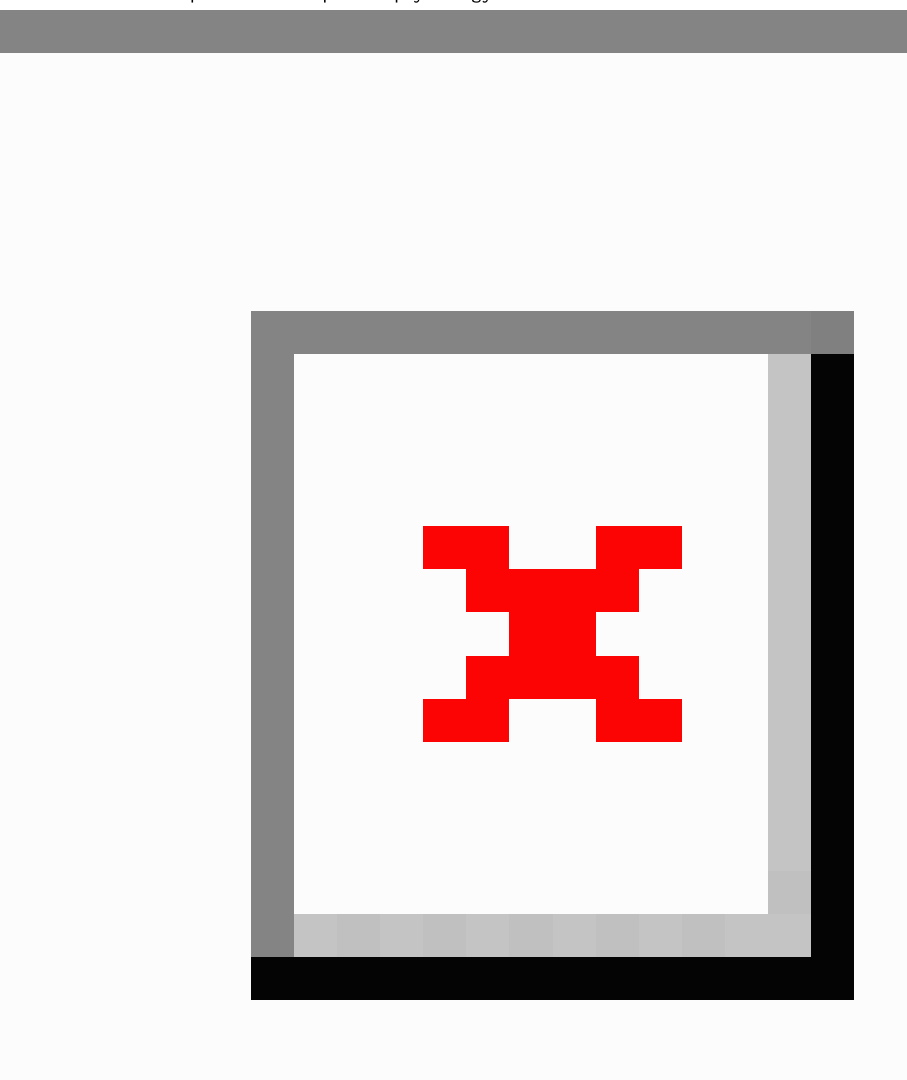
Figure 3. Emotional valence expressed toward positive psychology